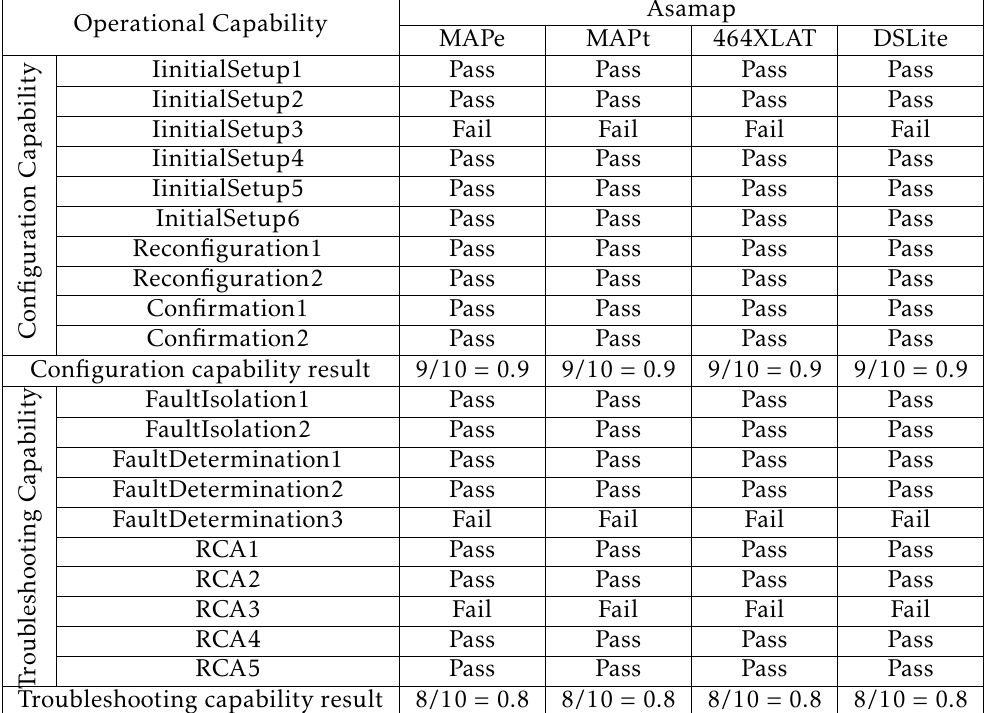
Table 5. Operational capability results